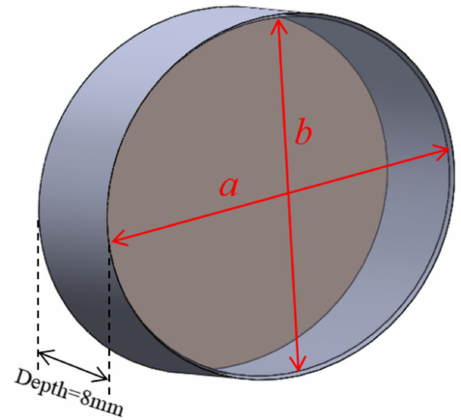
Figure 1. Ellipsoid rotary drum